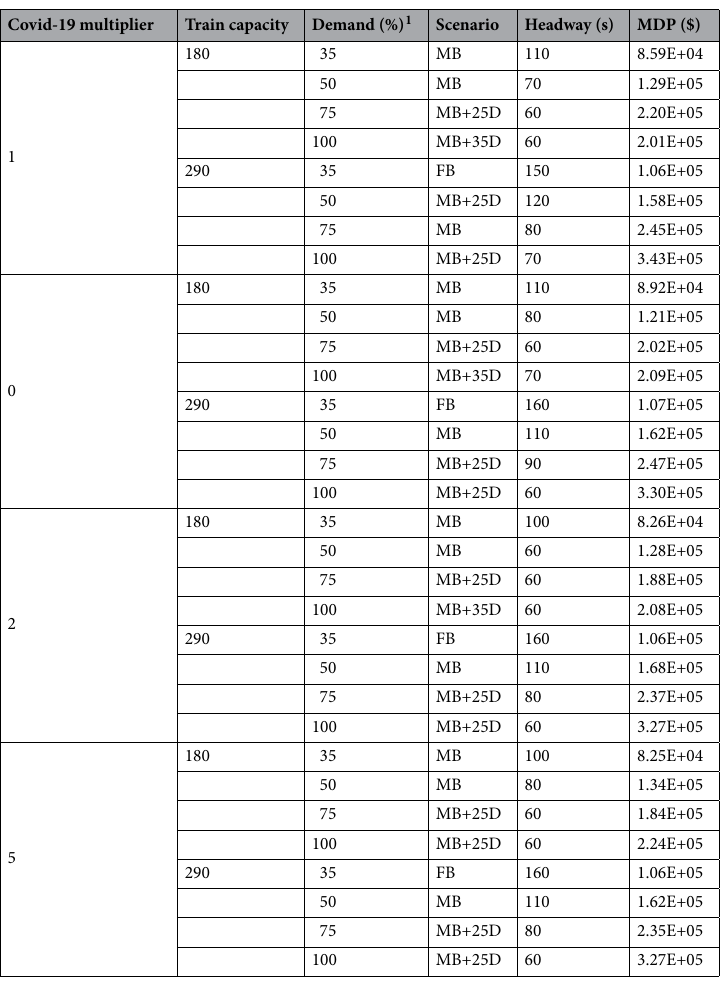
Table 2. Best performing operational scenarios by train capacity, demand level, and Covid-19 crowding multiplier. MB base moving block, MB+25D moving block with 25 s minimum dwell time, MB+35D moving block with 35 s minimum dwell time, FB fixed block. 1 Demand is reported as a percentage of 2019 demand